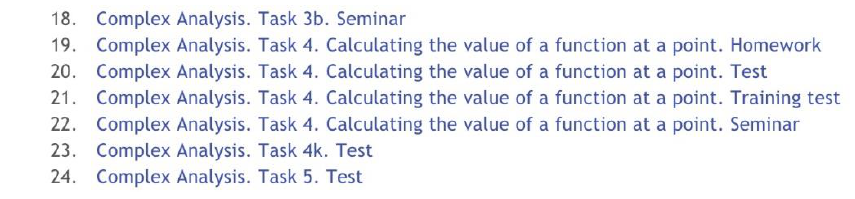
Fig. 4. Example of tasks structure in DLS